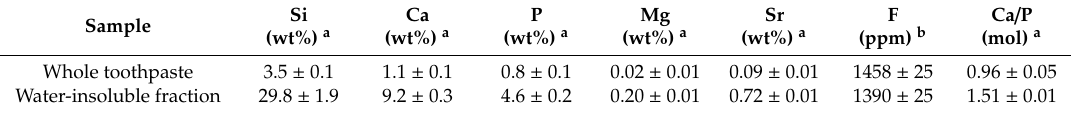
Table 2. Chemical composition of the whole toothpaste and the water-insoluble